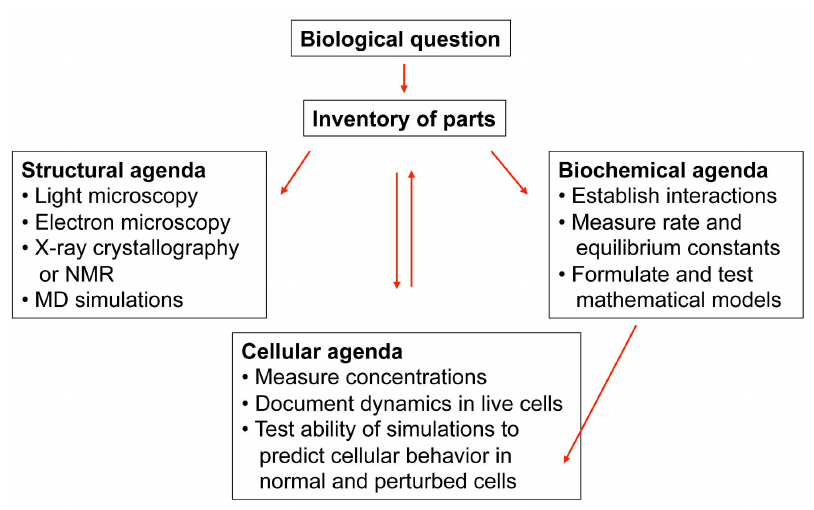
Figure 1. Diagram of the reductionist–synthetic strategy to characterize biological mechanisms. The boxes show the steps and research methods that contribute to understanding molecular mechanisms in cell biology. Arrows show the progression of the work starting with the definition of a biological question, followed by collecting an inventory of the relevant molecules and then three large areas of research: structural studies, cellular observations and biochemical characterization. When simulations of the hypothesis fail to account for observations in cells (bottom box), the investigator must reexamine their assumptions about the participating molecules (upward center arrow) and the participating reactions (right box) and the numerical parameters used in the simulations. Simulations and observations converge as understanding